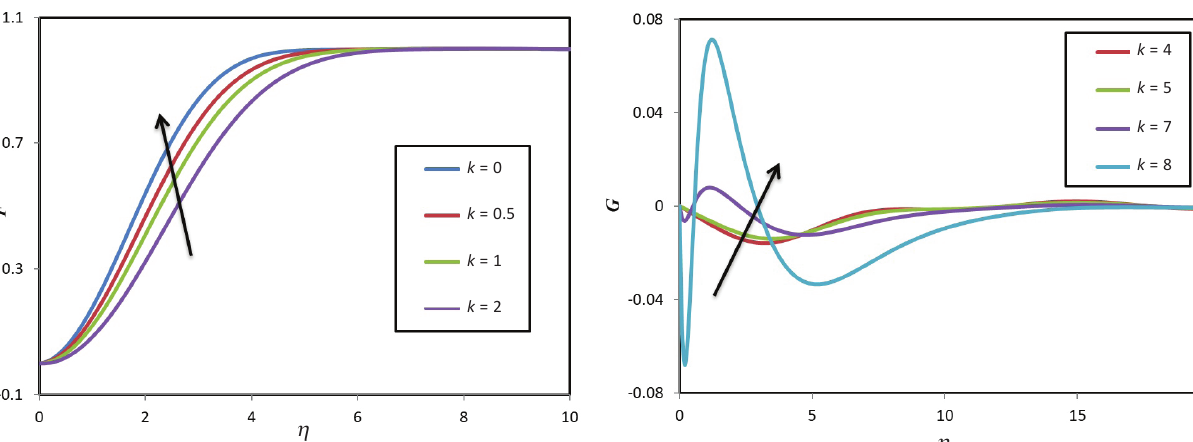
Fig. 11 – G (secondary velocity) versus h for I = 0.5, F = –0.5 (heat sink), Pr = 100 (weak polymers), m = 0.3 (general wedge flow), Ec = 0.2, with K = 4, 5, 7, 8